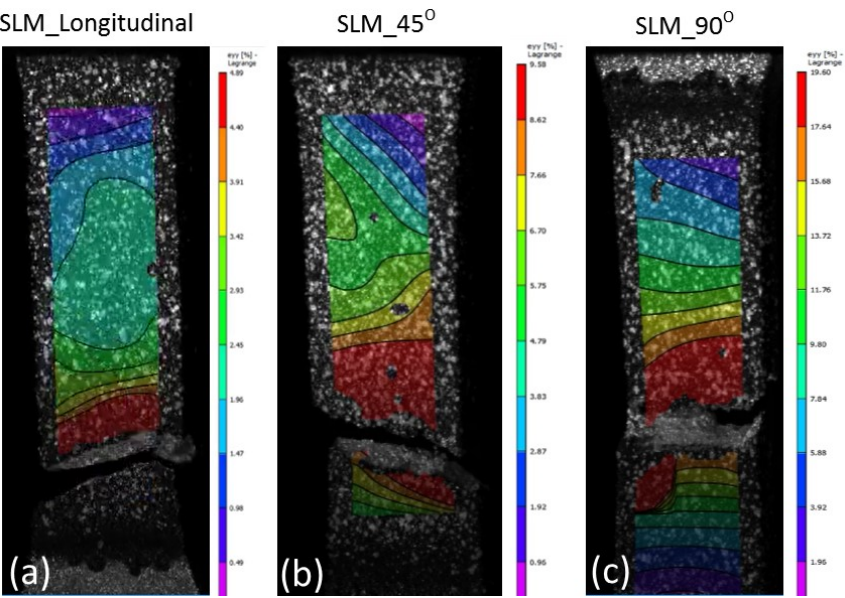
Figure 8. DIC images showing all samples at fracture states of SLM material. Note the maximum elongations at fracture locations were about ( a ) 5%, ( b ) 10% and ( c ) 19.5% on the 0°, 45° and 90°, respectively.